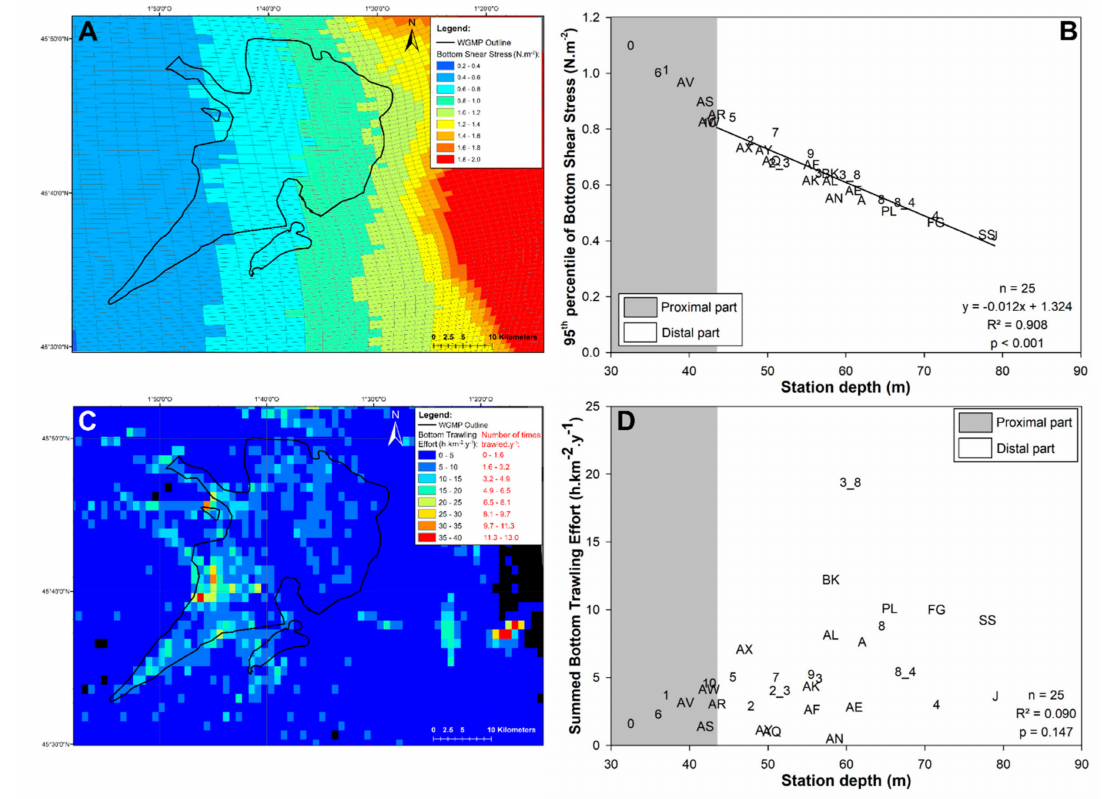
Figure 9. Spatial mapping of 95th percentile of Bottom Shear Stress during the year preceding the JERICOBENT-5 cruise ( A ), relationship with station depth within cells including sampled stations ( B ), summed Bottom Trawling Effort during the year preceding the JERICOBENT-5 cruise ( C ), and relationship with station depth within cells including sampled stations ( D ). Gray areas represent the proximal part (z < 42.5 m) of the WGMP. Station codes are the same as in Figure 1 and Table